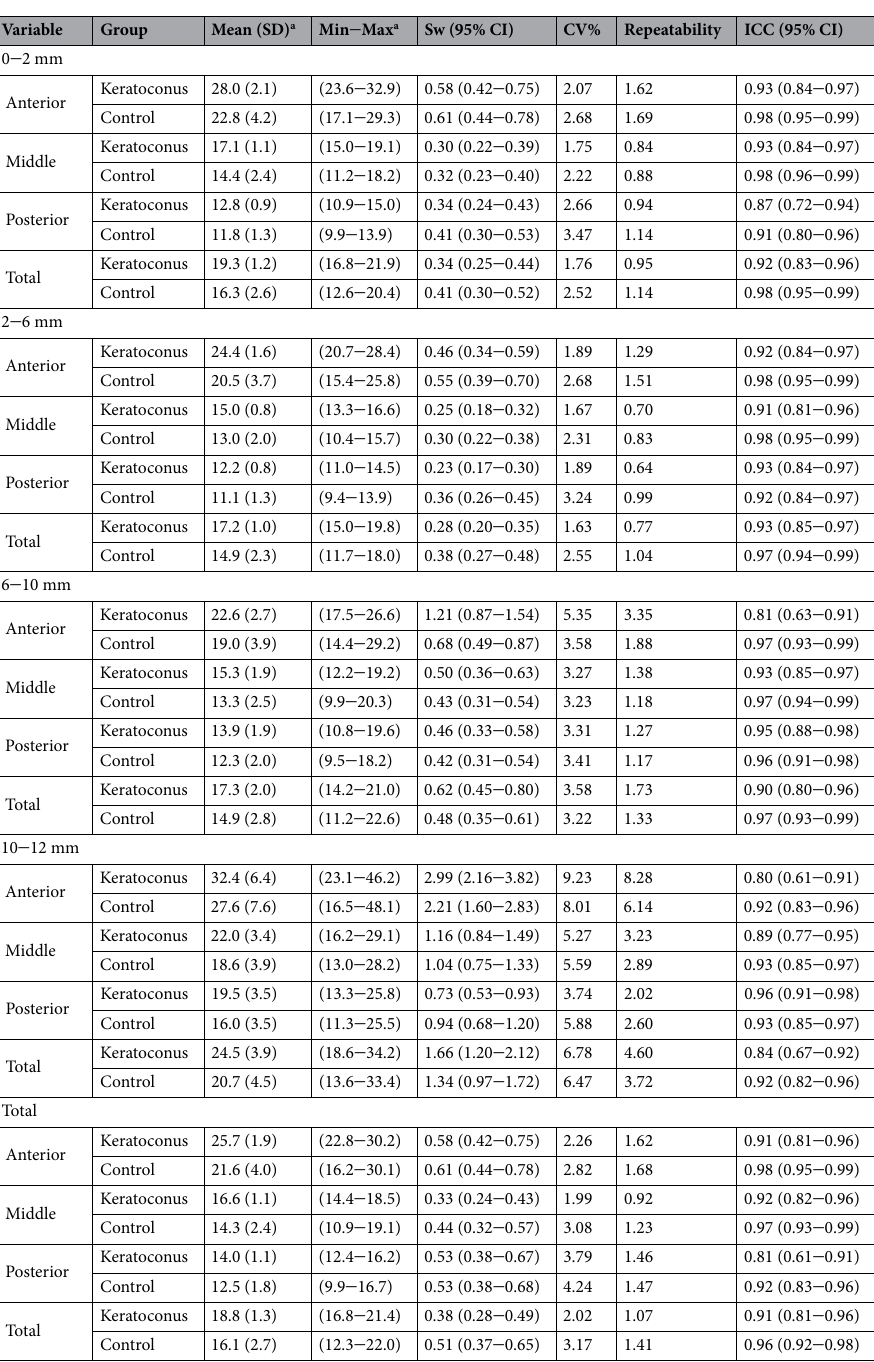
Table 5. Descriptive statistics and inter-day repeatability of measurements using a mean of four replicates in subjects with keratoconus and healthy controls. a Subject mean. The values are presented in greyscale units. Standard deviation (SD), S w (Within-subject standard deviation, CI (confidence intervals), CV% (coefficient of variation), ICC (Intraclass correlation